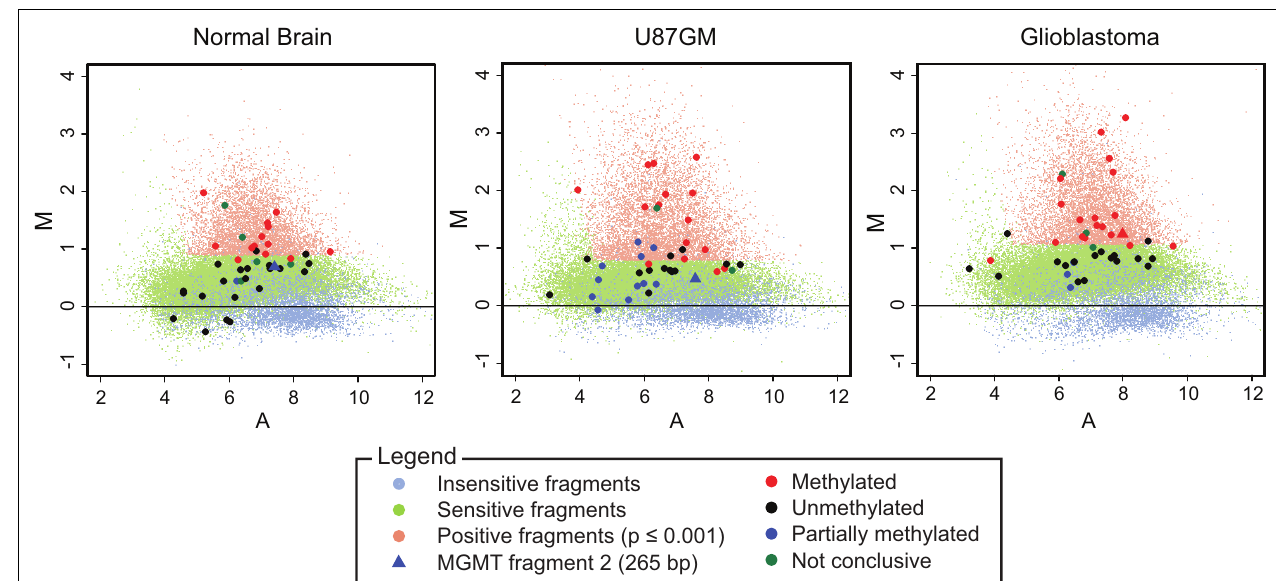
FIGURE 5 | Bisulfi te sequencing validation results superimposed on MA plots. Bisulfi te sequencing results ( Table 2 ) were mapped on the corresponding MA plots for normal brain, U87MG and GBM DNA samples. Red dots represent validated methylated fragments (all CCGG sites are methylated in tandem), black dots represent fully unmethylated fragments, and blue dots represent mixed